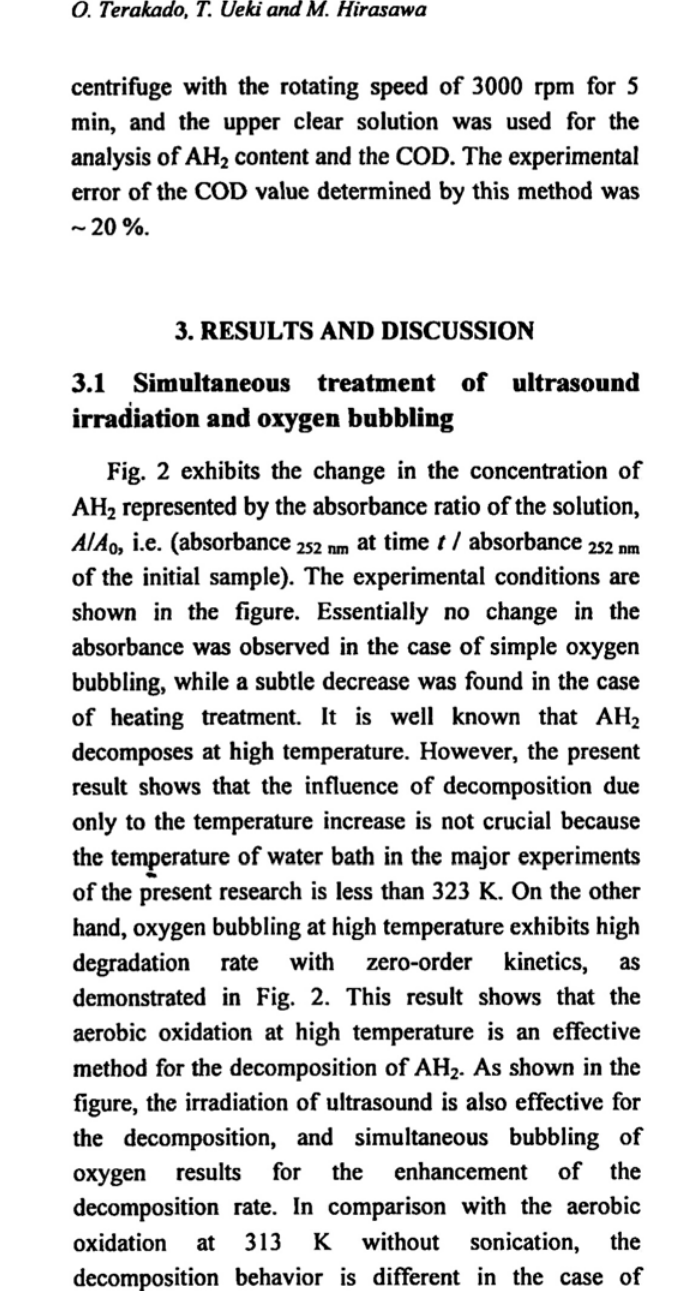
Fig. 2: Comparison of decomposition behavior of AH by various treatments.